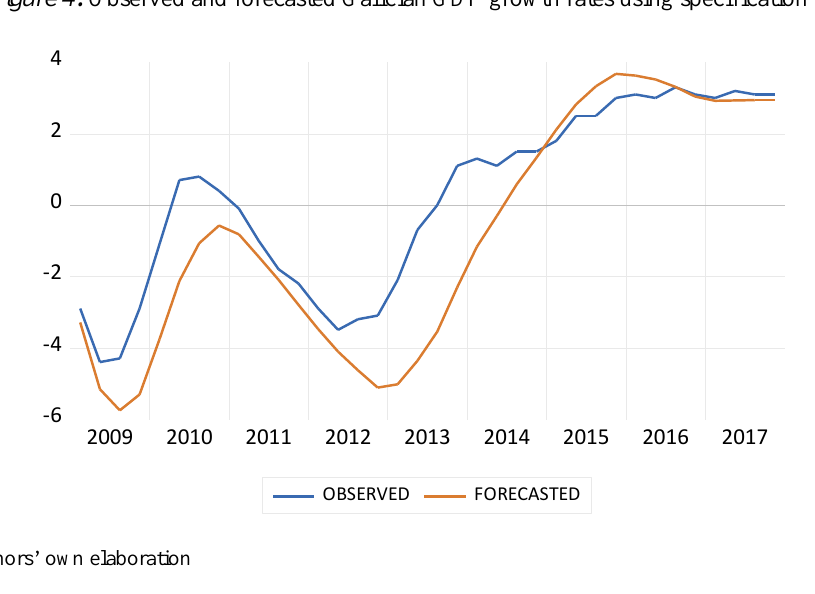
Figure 4: Observed and forecasted Galician GDP growth rates using specification